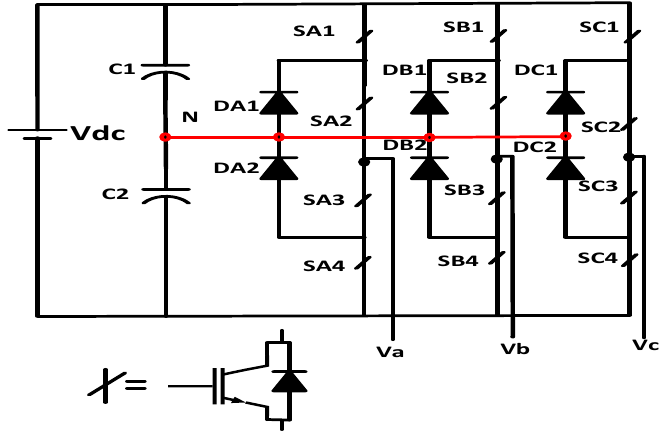
Figure 3. Topology of the diode clamped three-level inverter.